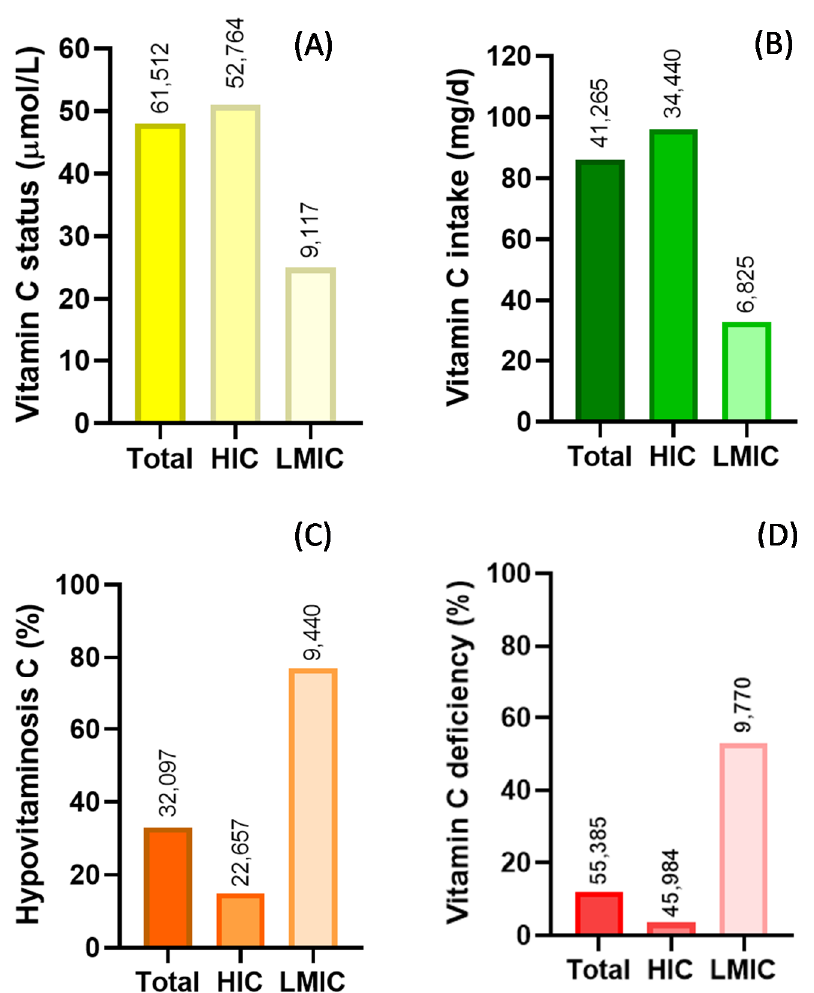
Figure 2. Summary of global vitamin C status ( A ) and intake ( B ) and prevalence of hypovitaminosis C ( C ) and vitamin C deficiency ( D ). Key: HIC—high-income countries; LMIC—low- and middle-income countries. Hypovitaminosis C, < 23 µ mol / L; vitamin C deficiency, < 11 µ mol / L. Numbers above bars indicate total number of individuals assessed.